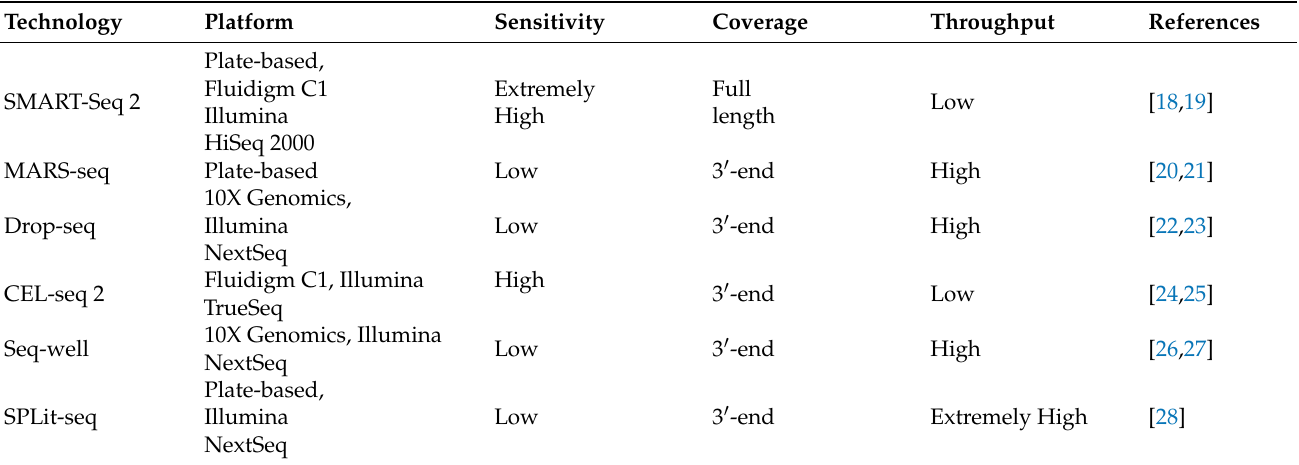
Table 1. Technologies and platforms for single-cell transcriptomic